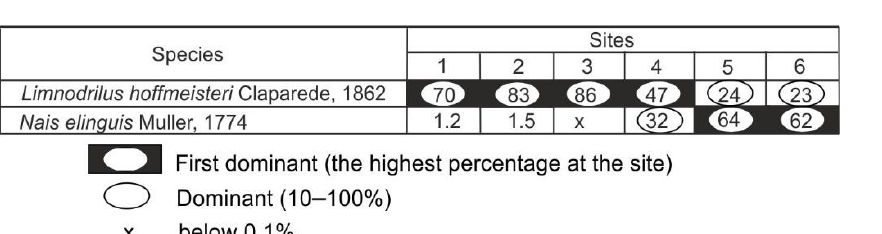
Figure 7. Percentage of dominant Oligochaeta species in the Vistula River in 1982–1983 (according to [27], modified).